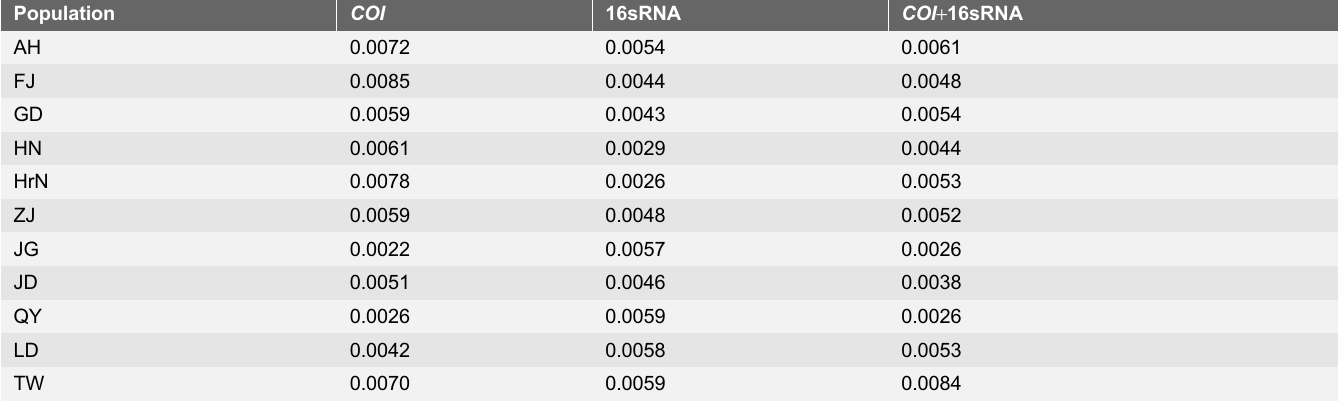
Table 4. Mean distance within tea green leafhopper populations based on COI , 16sRNA and combined